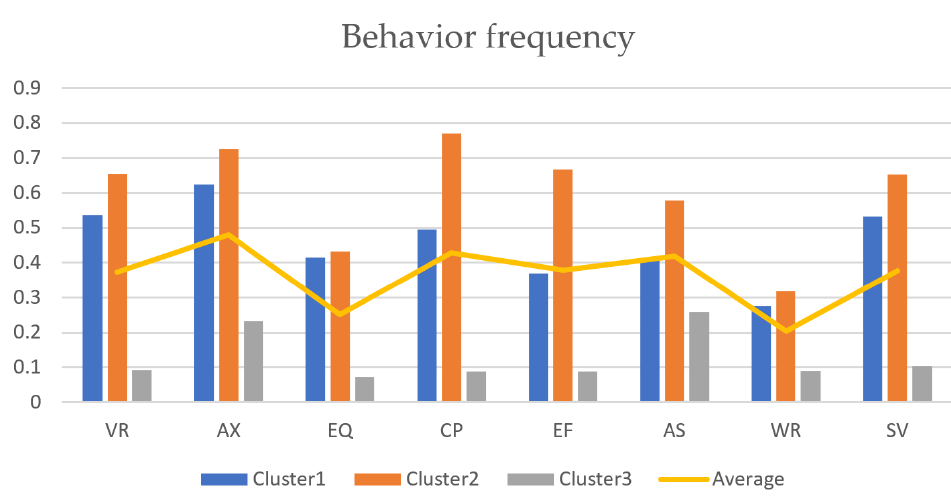
Figure 2. Comparison of behavior frequency of different clusters.